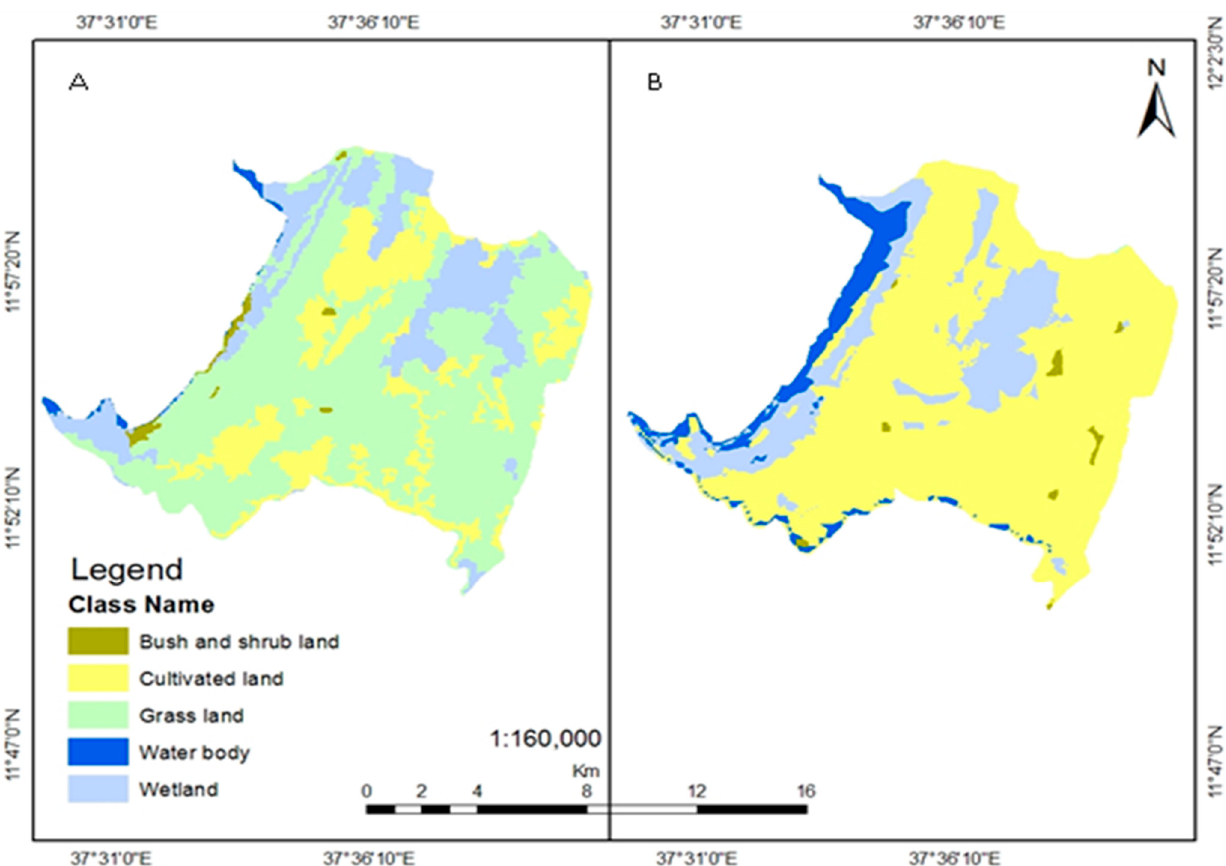
Figure 5. Land use land cover map of the study area. A) Land use class in 1973 B) Land use class in 2014.